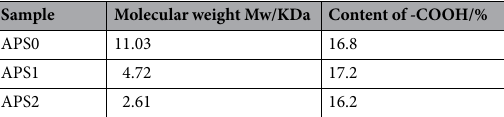
Table 1. Molecular weight and -COOH group contents of